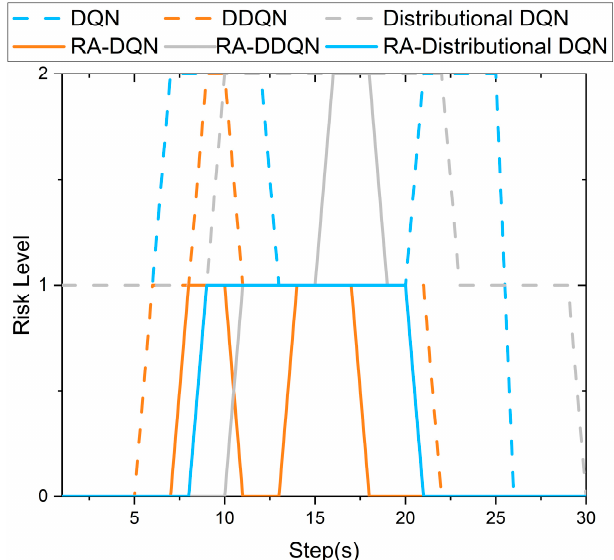
Figure 17. Intersection scenario test results: RA denotes that the algorithm uses a risk assessment method; 0 denotes that the risk level is safe; 1 denotes that the risk level is attentive; and 2 denotes that the risk level is dangerous.